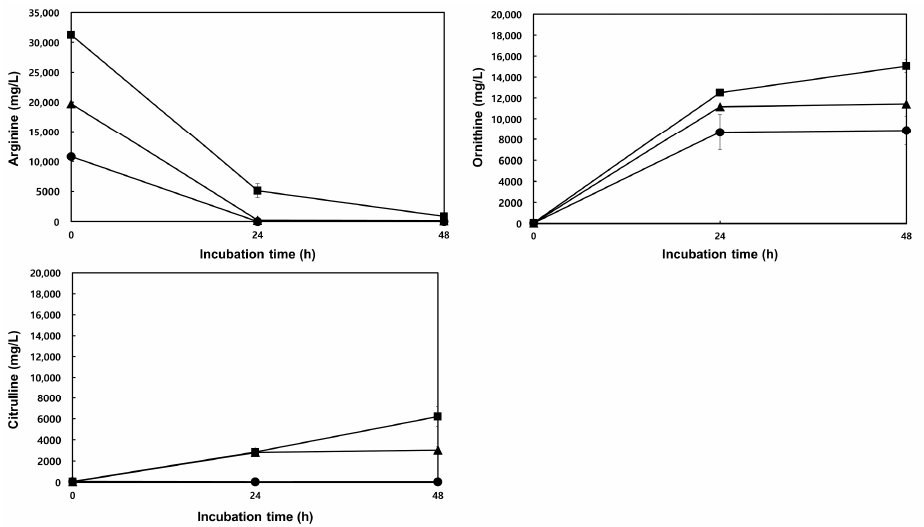
Figure 4. Ornithine and citrulline production by W. koreensis DB1. W. koreensis DB1 was cultivated in MRS broth supplemented with 1.0% ( ● ), 2.0% ( ▲ ), or 3.0% ( ■ ) arginine (initial pH, 5.0) at 30 °C for 24– 48 h. Levels of arginine, citrulline, and ornithine in cultures were determined by HPLC as described in Materials and Methods.